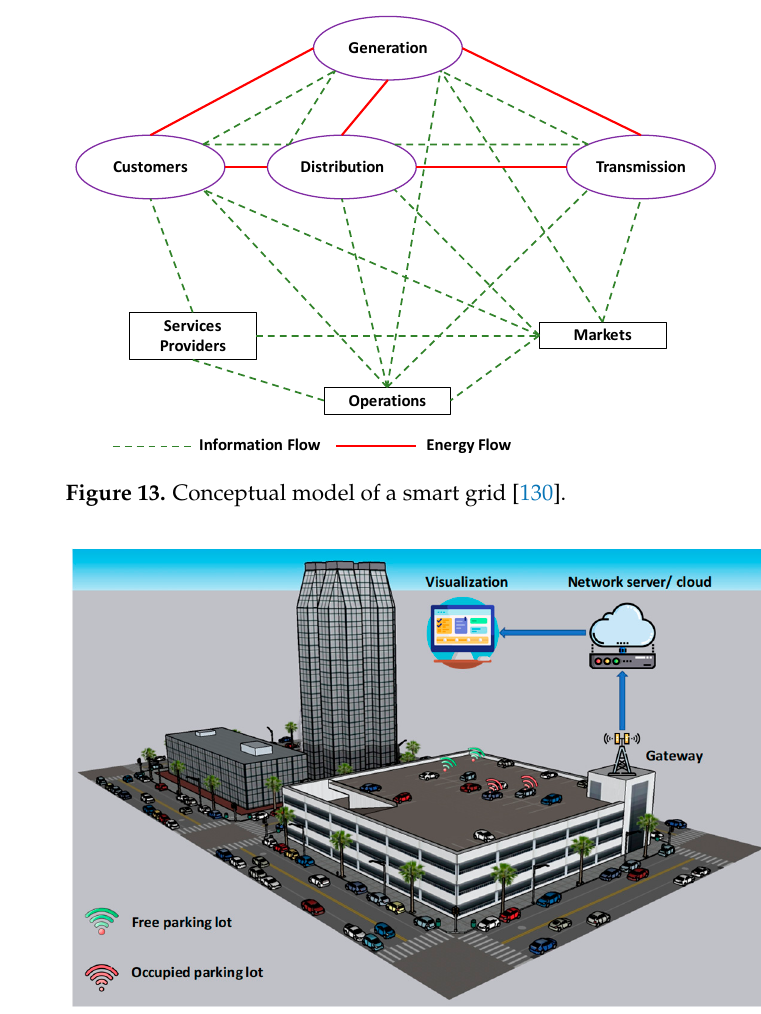
Figure 14. IoT-based Smart Parking System.